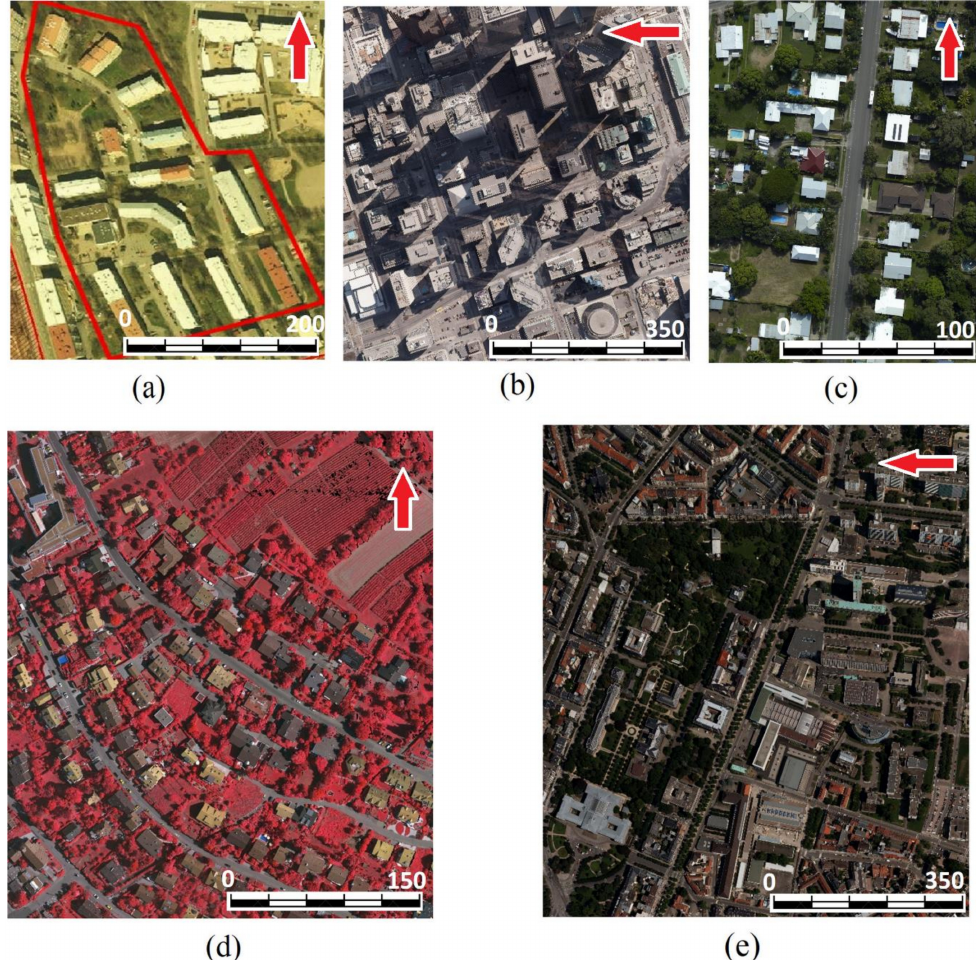
Figure 11. Locations of the study areas: ( a ) Hermanni; ( b ) Toronto; ( c ) Aitkenvale; ( d ) Vaihingen; ( e )